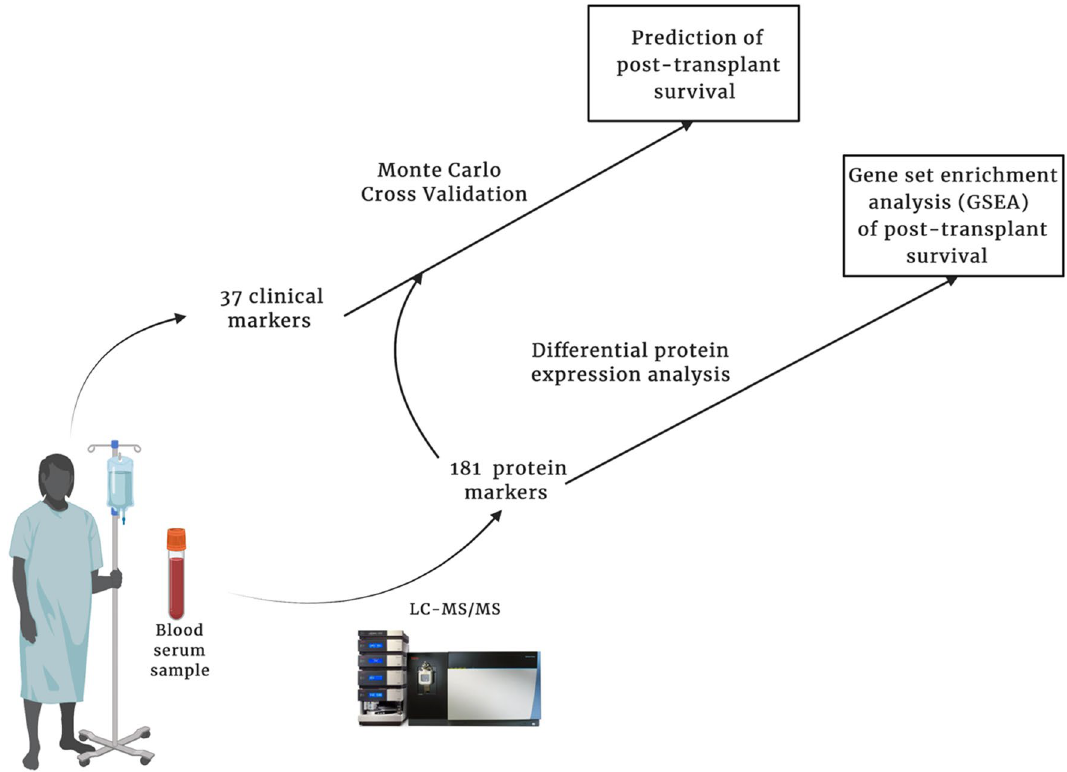
Figure 1. Study overview. Patient’s blood were drawn and serum was processed according to protocol at the clinical site (see “Methods”). We employed Monte Carlo Cross Validation (MCCV; See “Methods” for complete algorithm) to quantify a prediction interval of all pre-transplant, recipient markers to predict patient survival after heart transplantation. Additionally, the eligible protein markers were used in a differential protein expression analysis. Figure made with